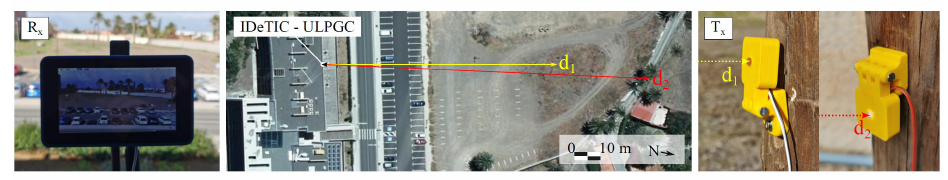
Figure 8. IDeTIC